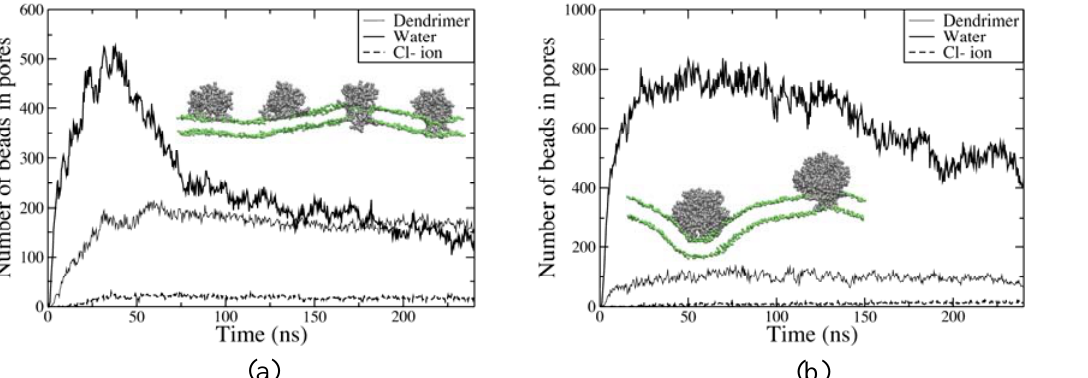
Figure 5 . Numbers of dendrimer, water molecules, and ion beads in pores as a function of time, starting from a state with no performation of the bilayer for (a) G5-16 and (b) G7-4c. Reprinted with permission from [31]. Copyright 2008 American Chemical